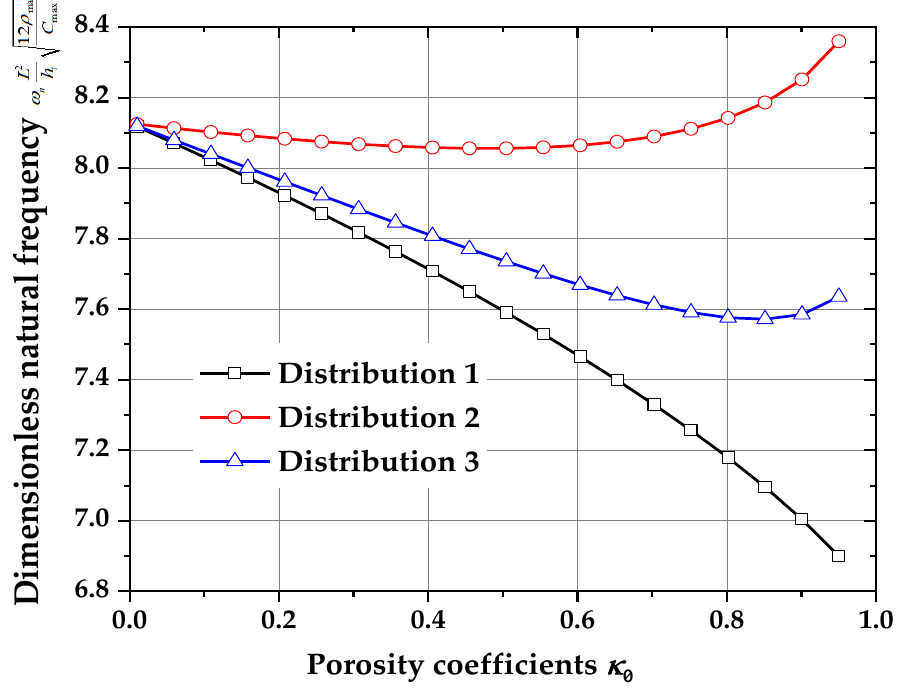
(cid:112) 12 ρ max / C max )-Porosity coefficient ( κ 0 )